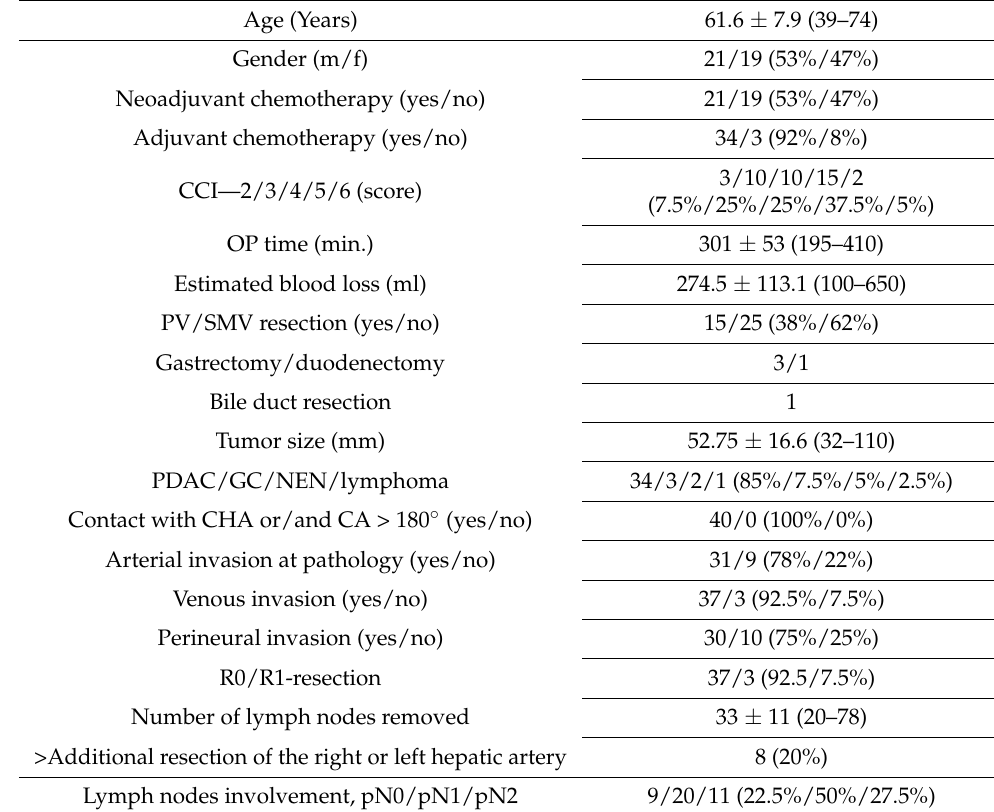
Table 1. Perioperative characteristics of the patients (n40).